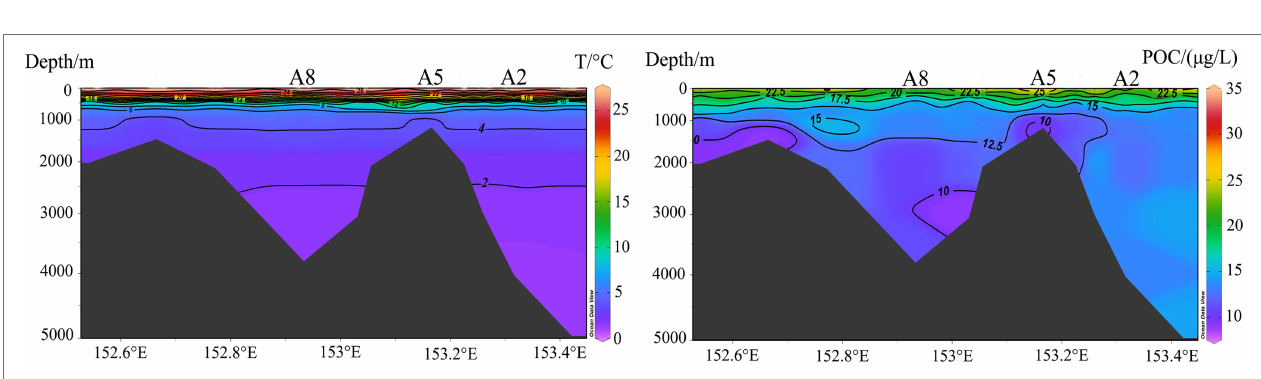
FIGURE 7 | Vertical distribution of water temperature and Particulate organic carbon (POC) in the Kocebu Guyot (modified from Ma et al.,